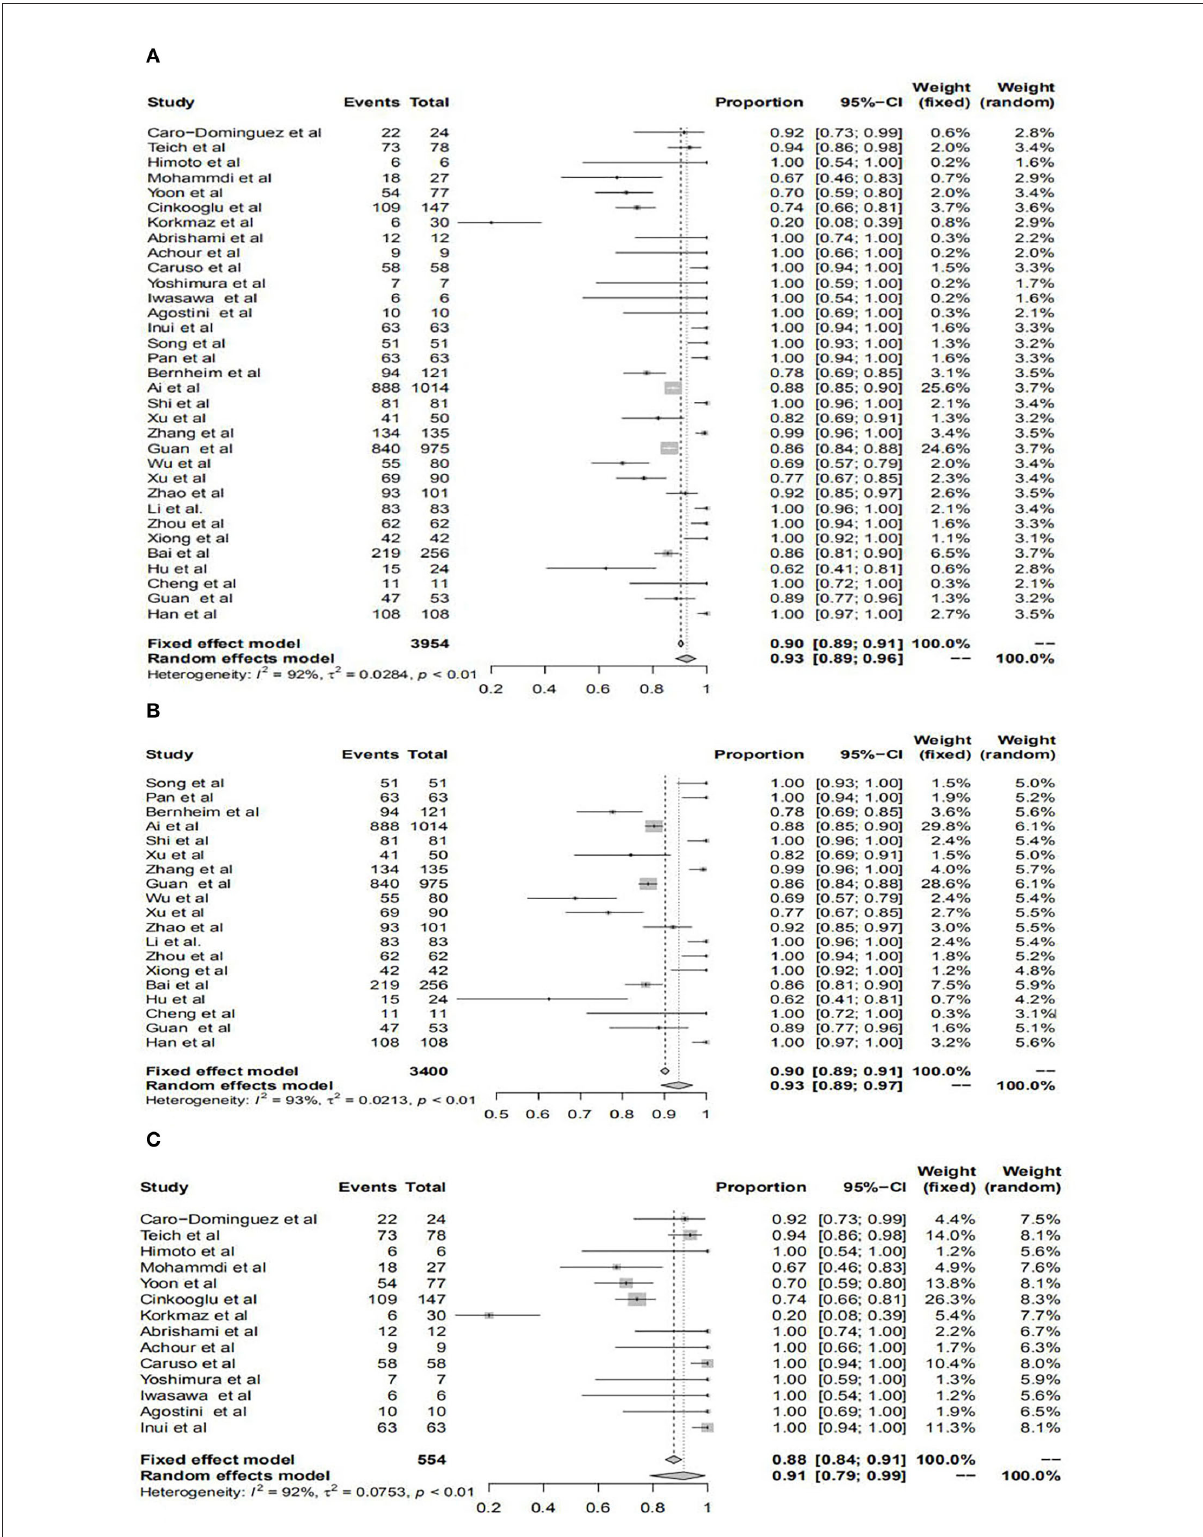
FIGURE2 Forest plots of the diagnostic performance of chest computerized tomography (CT) in studies included in the meta-analyses. Forest plots show the prevalence of positive chest CT for all patients (A) , patients within mainland China (B) , and patients outside mainland China (C)